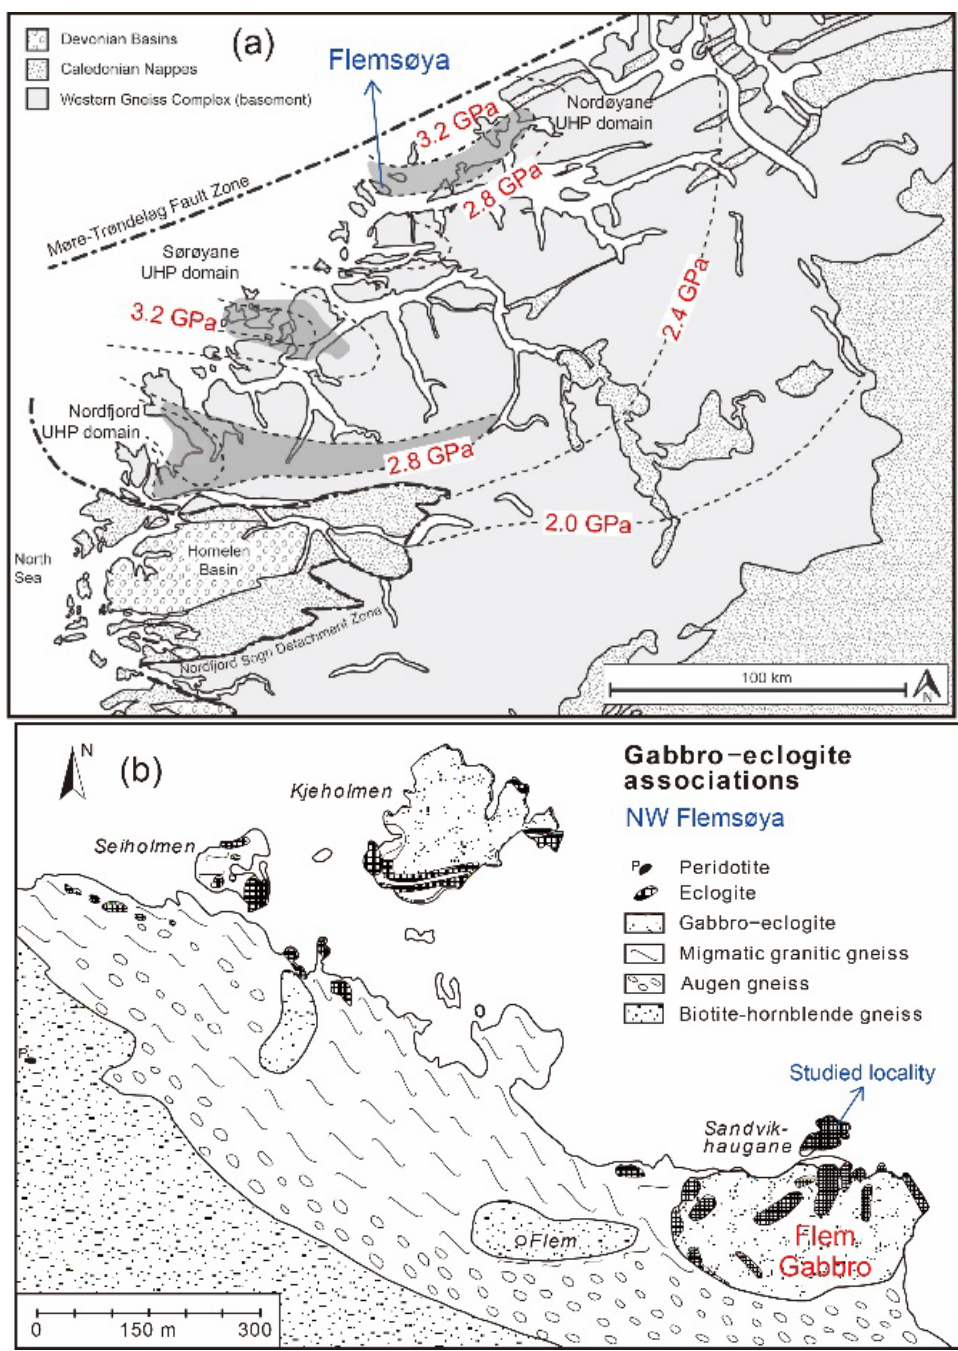
Figure 1. ( a ) Geological map showing the Western Gneiss Region (WGR) (modified from Renedo et al. [43]). The dark gray shaded area includes three ultrahigh-pressure (UHP) domains (Nordfjord, Sørøyane, and Nordøyane) along the western coast of the WGR. The dashed lines are isobars of peak metamorphic pressures. The blue arrow indicates the Flemsøya region where our eclogite samples were collected. ( b ) Geological map of the NW part of Flemsøya showing the distributions of eclogite (modified from Mørk [33] and Terry and Robinson [38]). The blue arrow indicates the locality where our eclogite samples were collected.